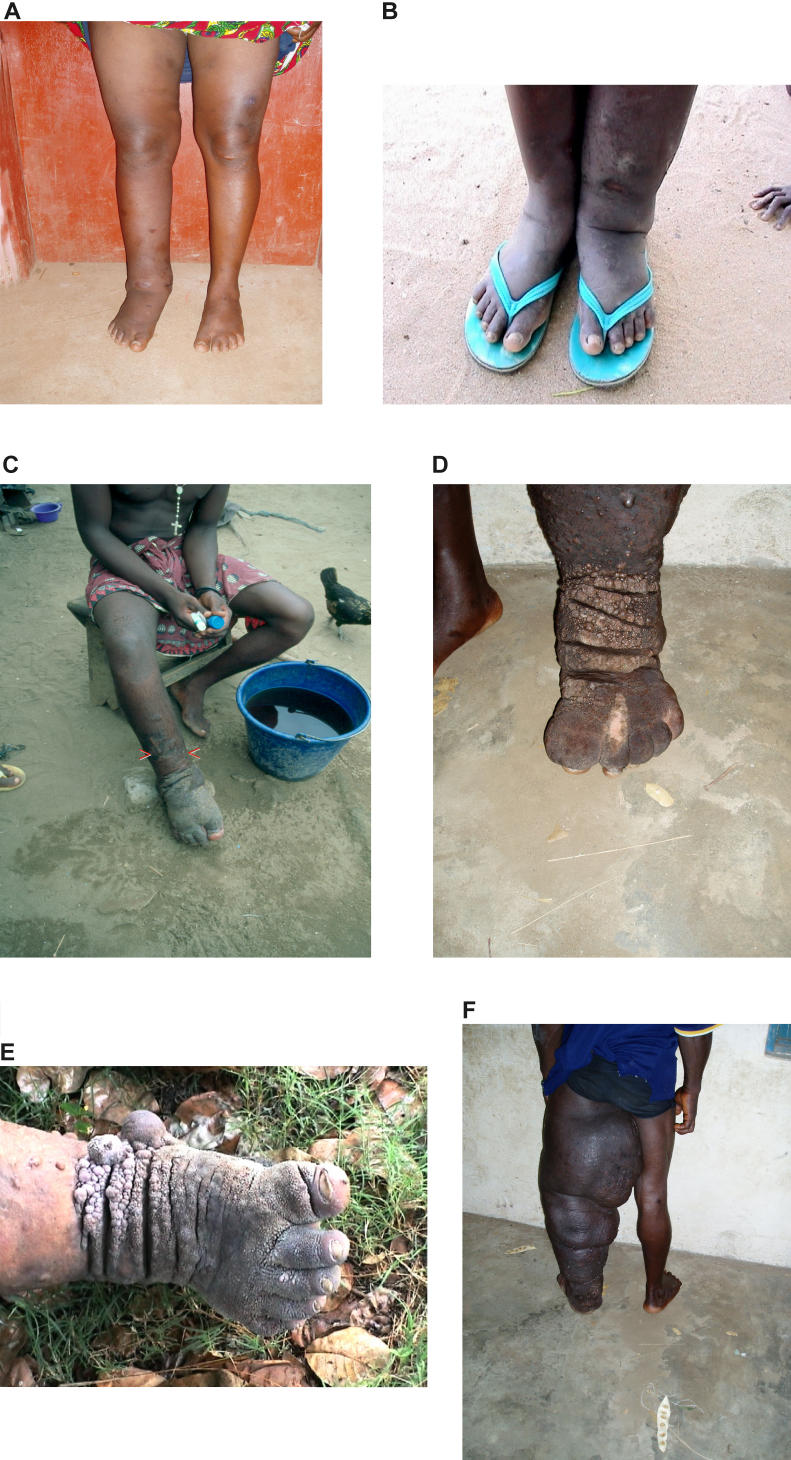
Lymphedema StagesThe lymphedema stages according to the classification by Dreyer et al. [47]; patients are from this study.(A) Stage 2, swelling that is not reversible overnight.(B) Stage 3, shallow skin folds at the ankle.(C) Stage 4, alteration of skin texture and formation of knobs (arrowheads).(D) Stage 5, presentation of deep skin folds in addition to the alterations of stage 4;(E) Satge 6, presentation of mossy lesion in addition to the alterations of stage 5.(F) Stage 7, inability of patient to perform daily work.